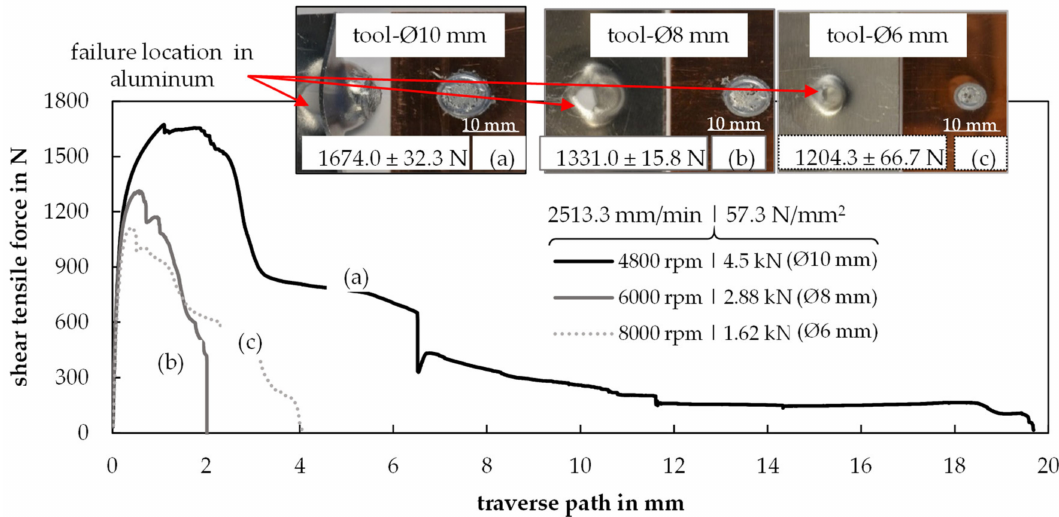
Figure 18. Effects of tool downscaling on the force-path curves and failure patterns of the welded samples.